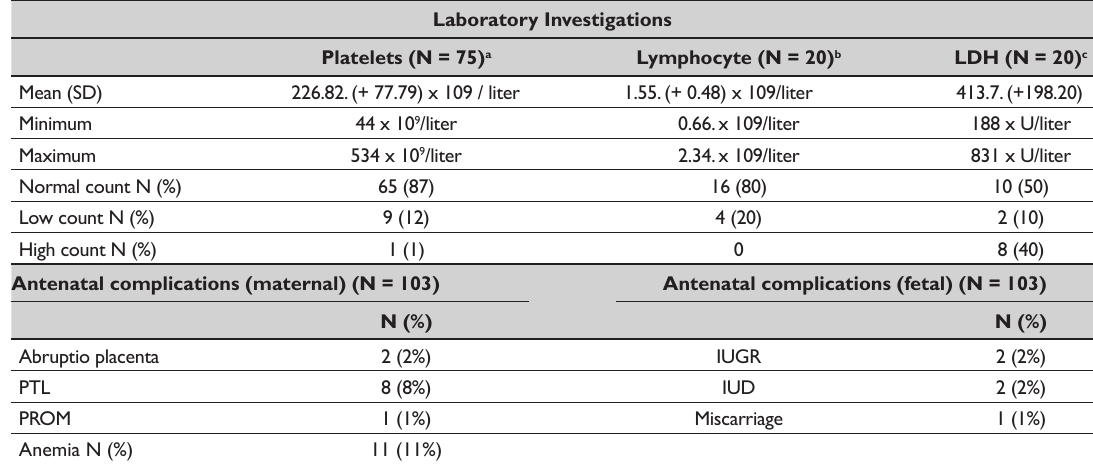
Table 3: Laboratory results and antenatal complications among COVID-19 positive pregnant and postpartum women, Ekurhuleni Health District, Gauteng province, South